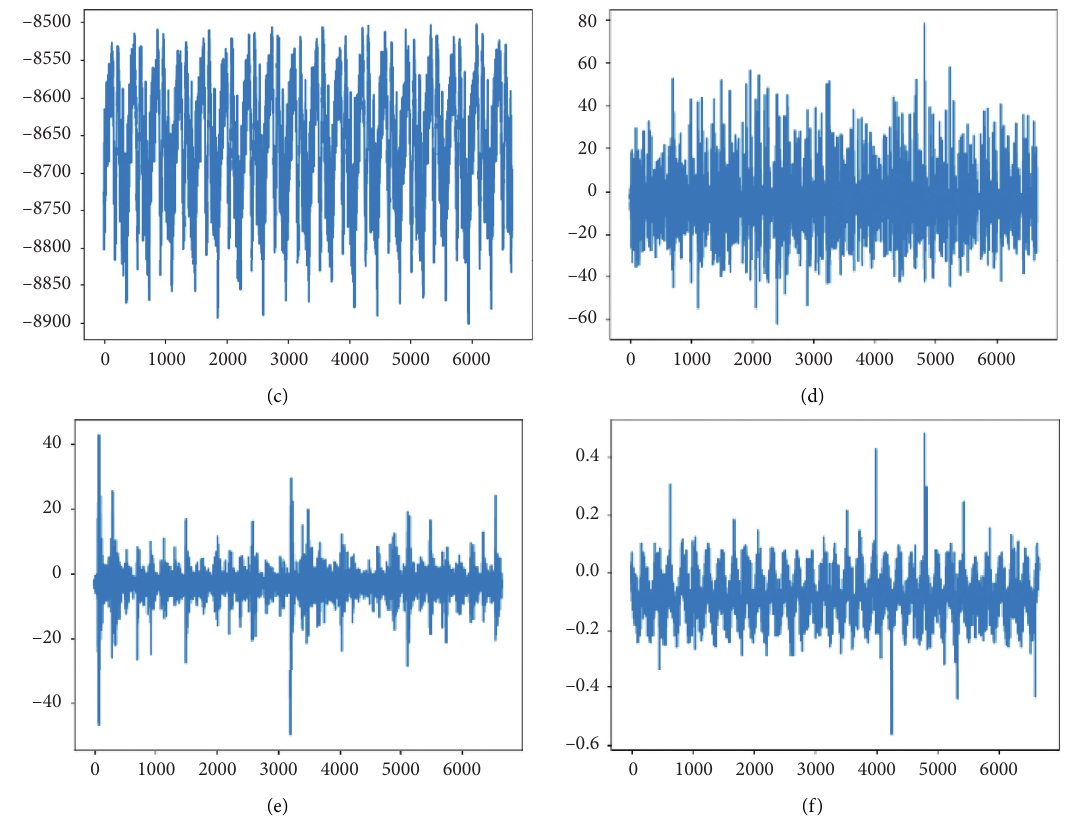
Figure 9: Time-domain waveforms of six different faults.